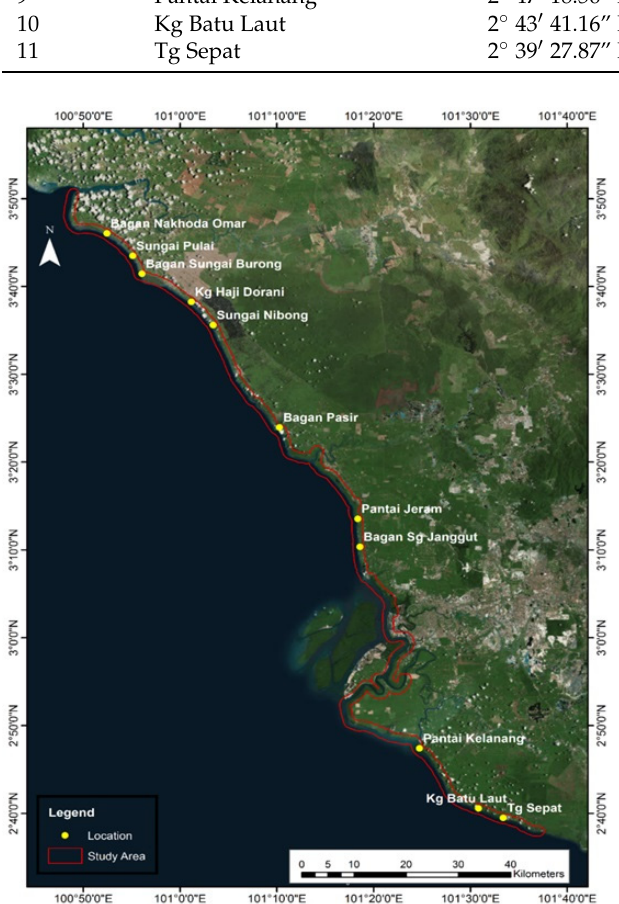
Figure 3. Study areas along coast of Selangor represented by the red line.